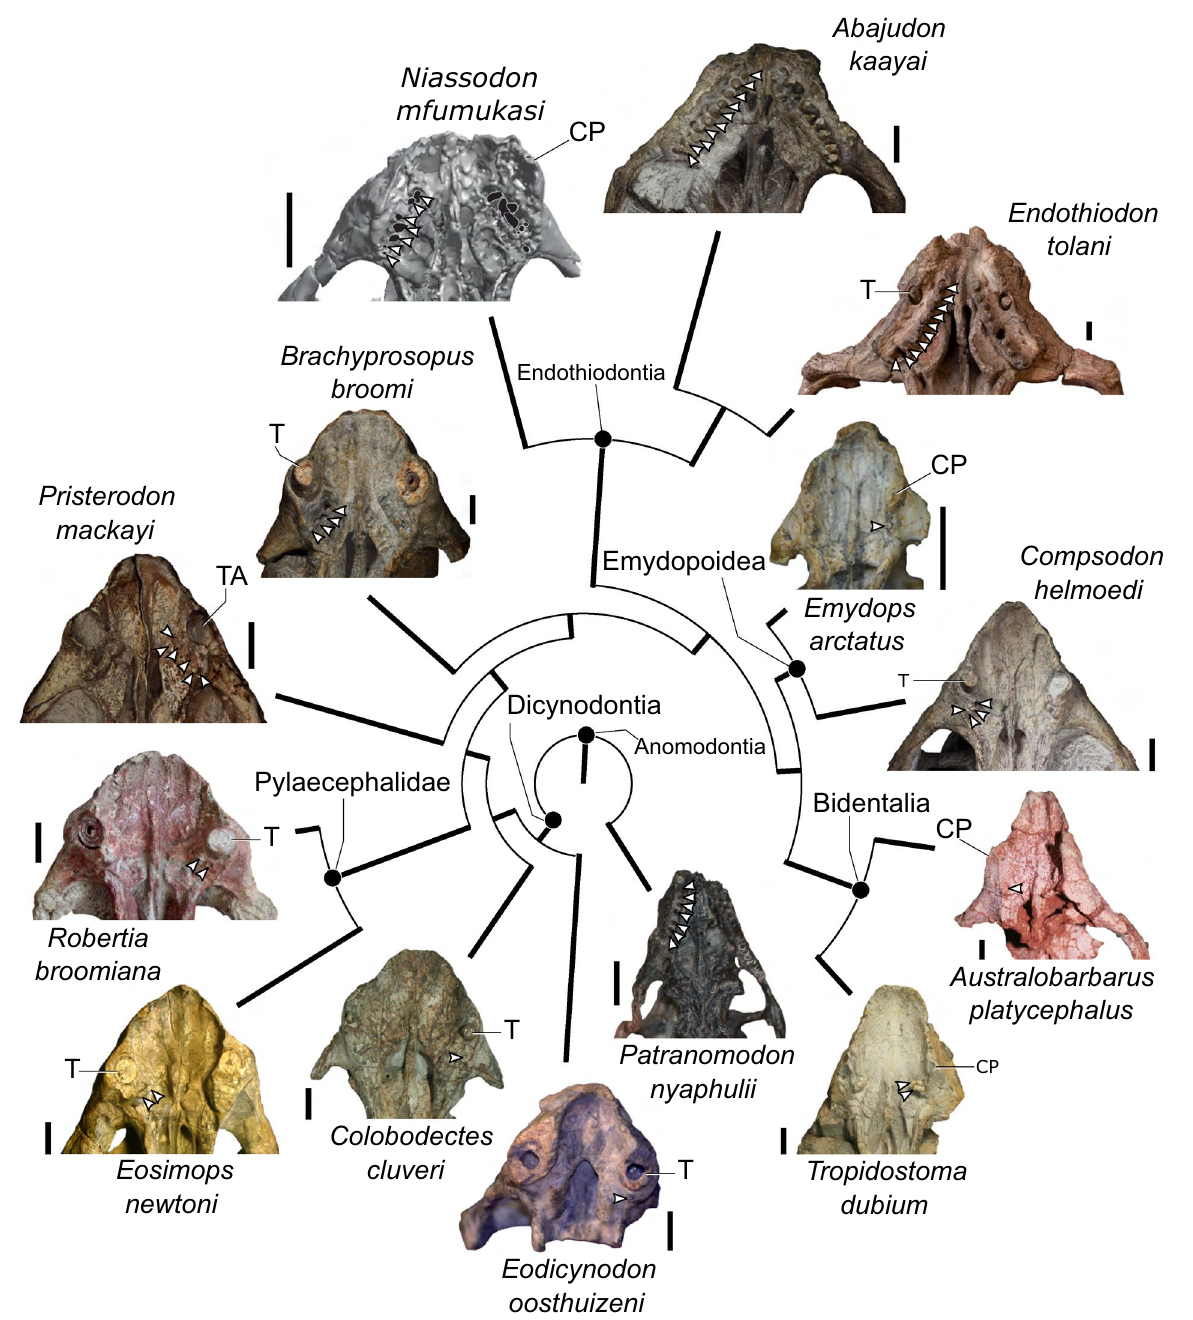
Figure 1. Simplified phylogeny showing different arrangements of the upper ‘postcanine’ teeth of dicynodonts; arrows indicate teeth or open alveoli. ‘Postcanines’ are typically located in the maxilla, although the anteriormost two teeth of Abajudon and Endothiodon are located in the premaxilla. Phylogeny based on Olroyd et al. 47 , Kammerer and Ordoñez 106 , and Angielczyk et al. 107 , but note that other topologies for Pristerodon, Brachyprosopus , the endothiodonts, and the emydopoids have appeared in recent phylogenetic analyses 42,108,109 . Branch lengths are arbitrary. Scale bars are 1 cm. Specimens: Patranomodon nyaphulii NMQR 3000; Eodicynodon oosthuizeni NMQR 2909; Colobodectes cluveri NMQR 3329; Eosimops newtoni USNM 23345; Robertia broomiana SAM-PK-K7807; Pristerodon mackayi NHCC LB355; Brachyprosopus broomi FMNH UR 2490; Abajudon kaayai NHCC LB314; Endothiodon tolani NHMUK PV R12443; Emydops acrtatus SAM-PK-11060; Compsodon helmoedi NHCC LB14; Tropidostoma dubium CGP/1/2173; Australobarbarus platycephalus PIN 4678/3. CP caniniform process, T tusk, TA tusk